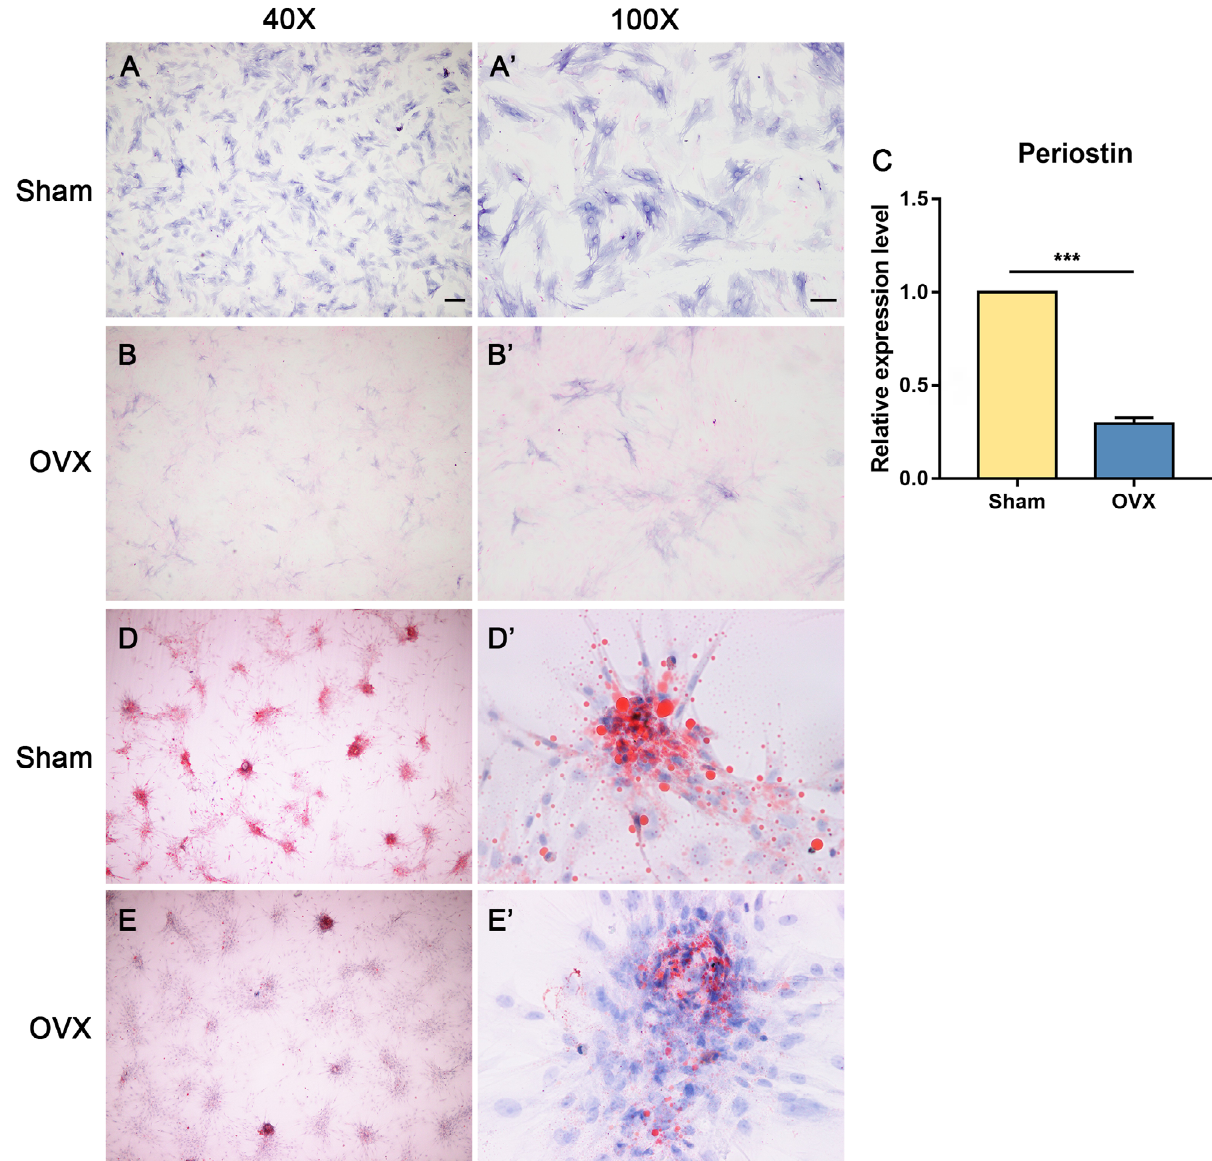
Figure 3 ‒ BMSCs derived from OVX rats exhibited impaired osteogenesis ability, adipogenesis ability and reduced expression of periostin. (A-B’) Representative images of ALP staining on day 7 after osteogenesis induction. (A, A’) Sham-BMSCs express ALP, while (B, B’) OVX-BMSCs express less ALP. (C) Graph shows the quantification of the relative expression level of periostin on day 7 after osteogenesis induction. Data are presented as the mean ± SD. *** P < 0.001. (D-E’) Representative images of oil red O staining on day 14 after adipogenesis induction. (D, D’) Sham-BMSCs exhibited intracellular lipid droplets. (E, E’) OVX-BMSCs exhibited less lipid droplets. The images are from 1 of 3 independent experiments. (A, B, D, E) Magnification × 40, scale bar = 100 μm. (A’, B’, D’, E’) Magnification × 100, scale bar = 200